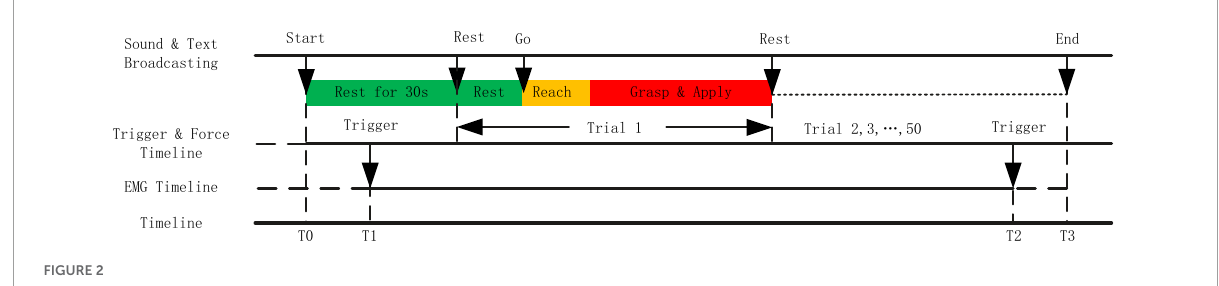
FIGURE2 The experimental paradigm based on the audio and visual cues and data synchronization scheme.